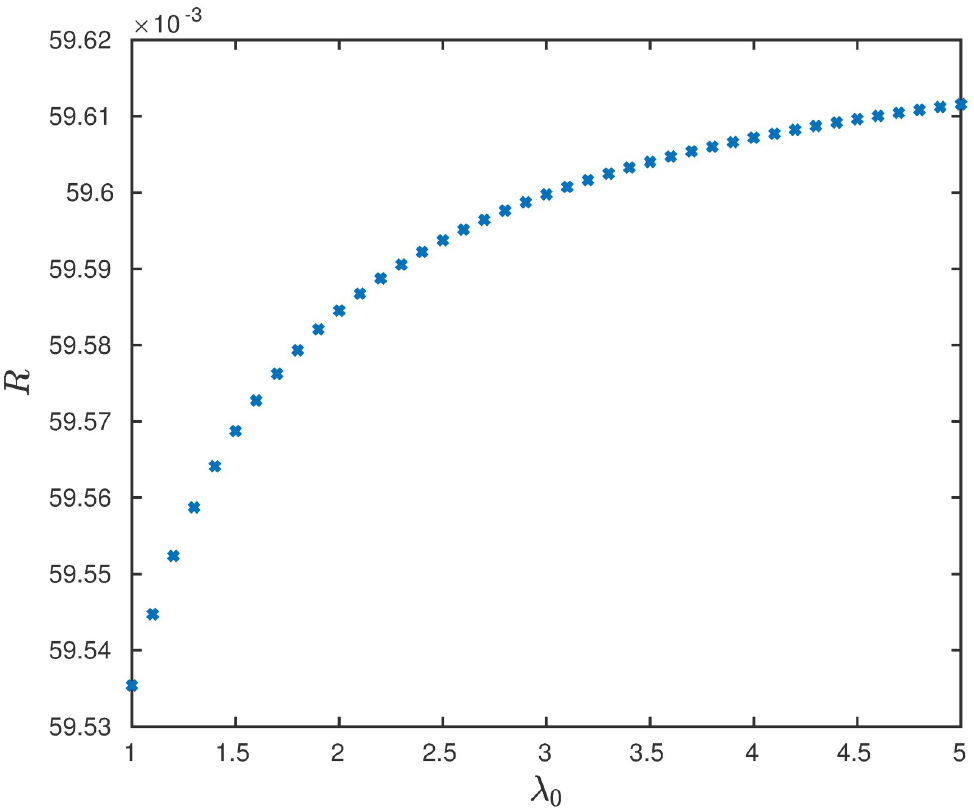
Fig 10. The steady-state output rate R as a function of λ 0 for a EFEIOD with n = 6, ℓ = 2, λ 0 = 1, λ i = 1, except λ 4 = 0.1, α i = 0, for all i , q = 1 and r =